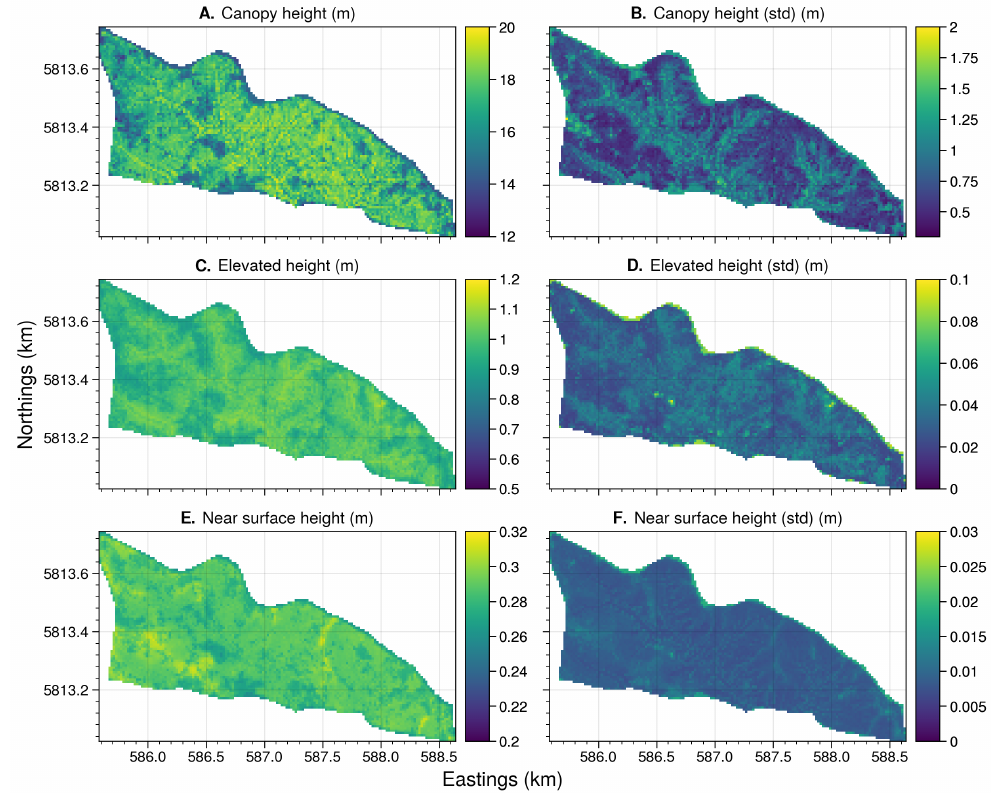
Figure A3. The mean and standard deviation predictions at landscape level for canopy ( A , B ), elevated ( C , D ) and near surface ( E , F ) fuel height using TLS observations at Lakes